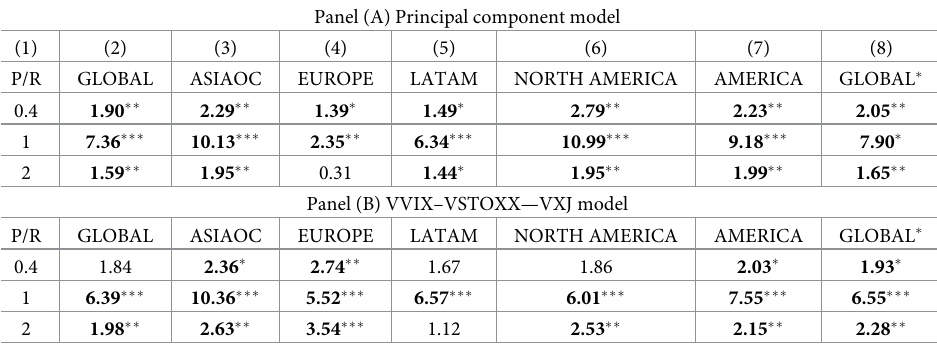
Table 7. Forecast variation in MSTL with volatilities principal